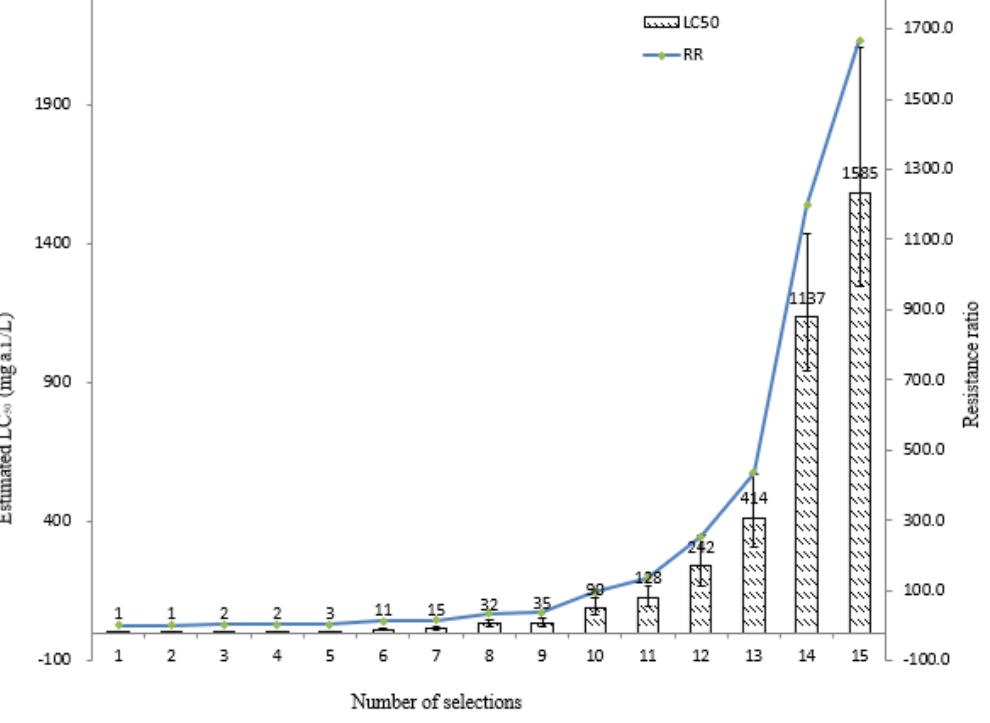
Figure 1. Changes in estimated LC 50 values of spirotetramat for the LS-FJ P. citri strain over 15 selection cycles. Detail LC 50 values are shown on each bar. The LC 50 s of the spirotetramat concentration–mortality curves were 0.95 mg L − 1 (95% CL 0.89–1.01) for the LS-FJ strain and 1589.01 mg L − 1 (95% CL 1355.94–1860.78) for the ST-NK (Figure 1) strain. An LC 90 value of 7036.69 mg L − 1 (95% CL 5359.62–10179.29)